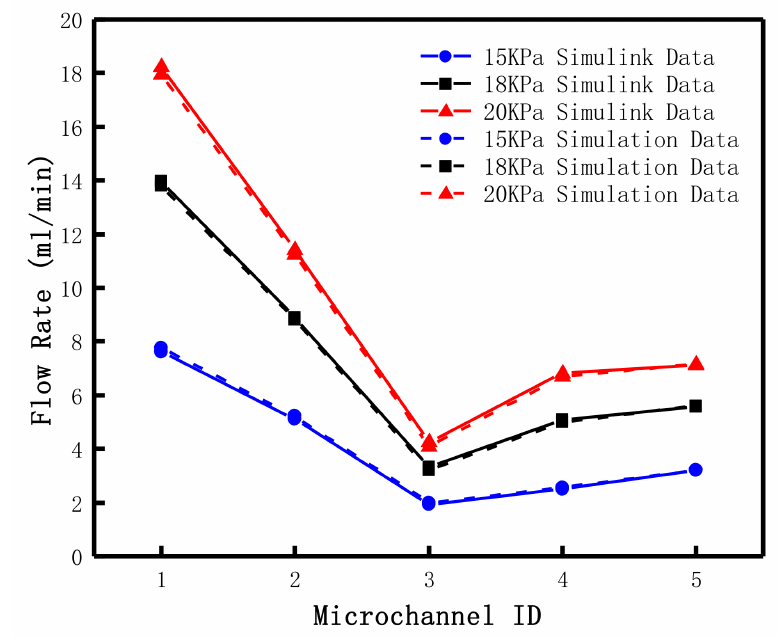
Figure 7. Schematic diagram of different driving